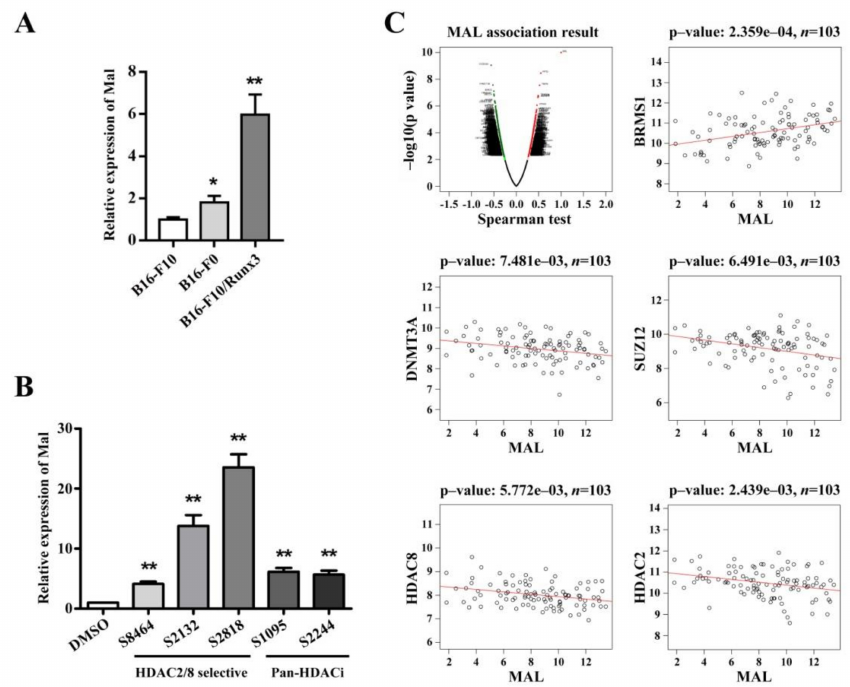
Figure 4. Mal gene expression was correlated with metastatic potential among the cell lines and was subject to epigenetic regulation. ( A ) Mal gene expression was validated in the cells used in this study with qRT-PCR. The relative Mal gene expression levels were compared among the indicated cell lines (means ± SEM, n = 3). ( B ) Treatment with histone deacetylase (HDAC) inhibitors induced the gene expression of Mal in B16-F10 cells. The relative Mal gene expression levels of inhibitor-treated cells were compared to those of untreated (DMSO) cells (means ± SEM, n = 3). ( C ) The gene expression of MAL was correlated with that of other genes in human melanoma. The top left panel indicates the overall MAL correlation. The other panels indicate the correlation between MAL and the other genes. The information about patient number and p -value is inscribed at each panel. The gene level at x / y axis is defined from FPKM. The p -values are generated by the Spearman correlation test. * p < 0.05 and ** p < 0.01 are generated by the t